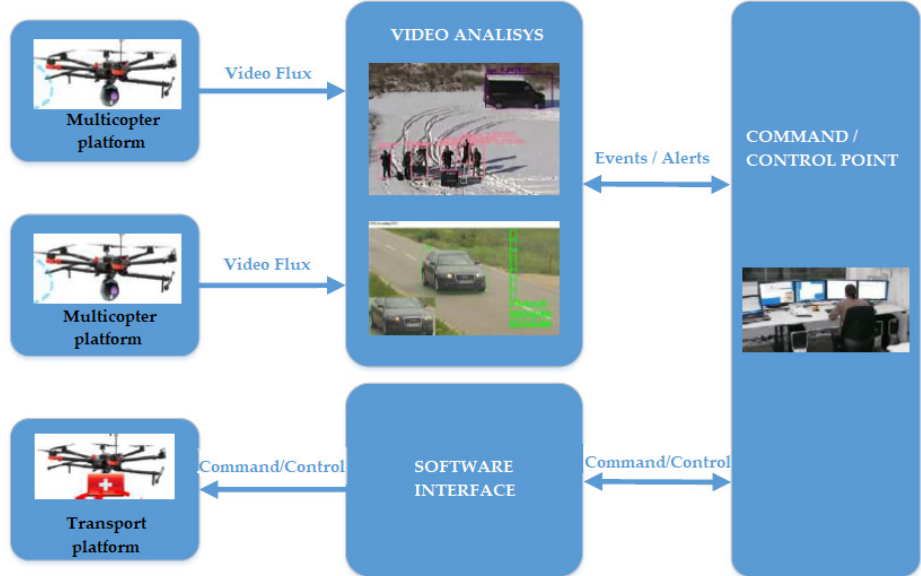
Figure 2. Software component of 19 Sol/UAV.